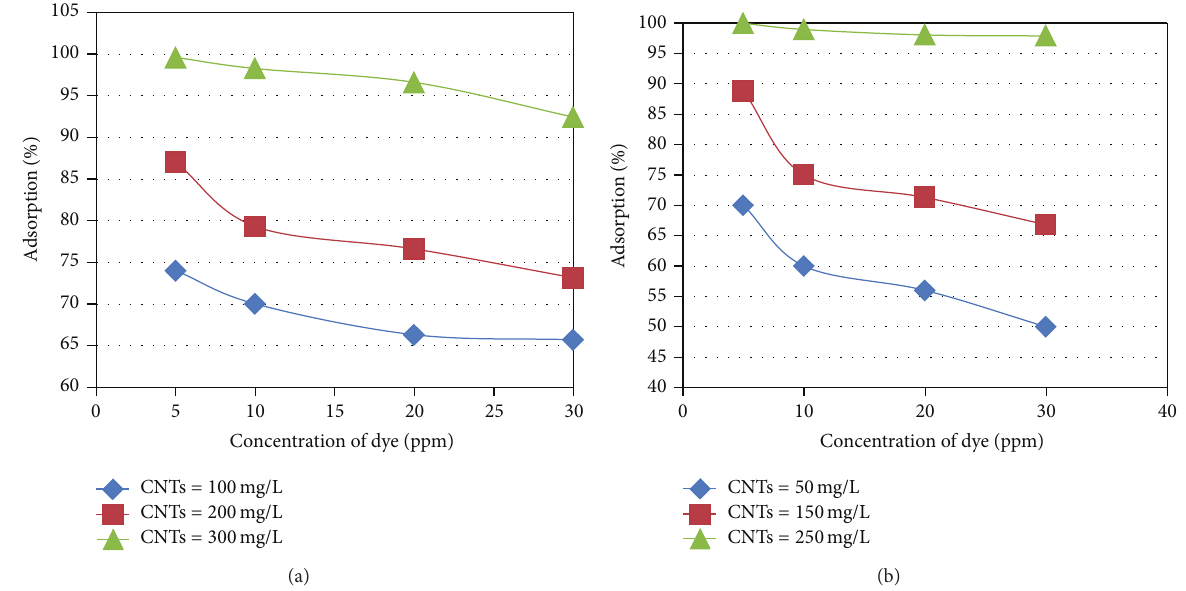
Figure 11: (a) Effect of basic orange dye initial concentration on adsorbed % (contact time = 30 min, pH = 8.5). (b) Effect of methyl violet dye initial concentration on adsorbed % (contact time = 40 min, pH = 8.5).